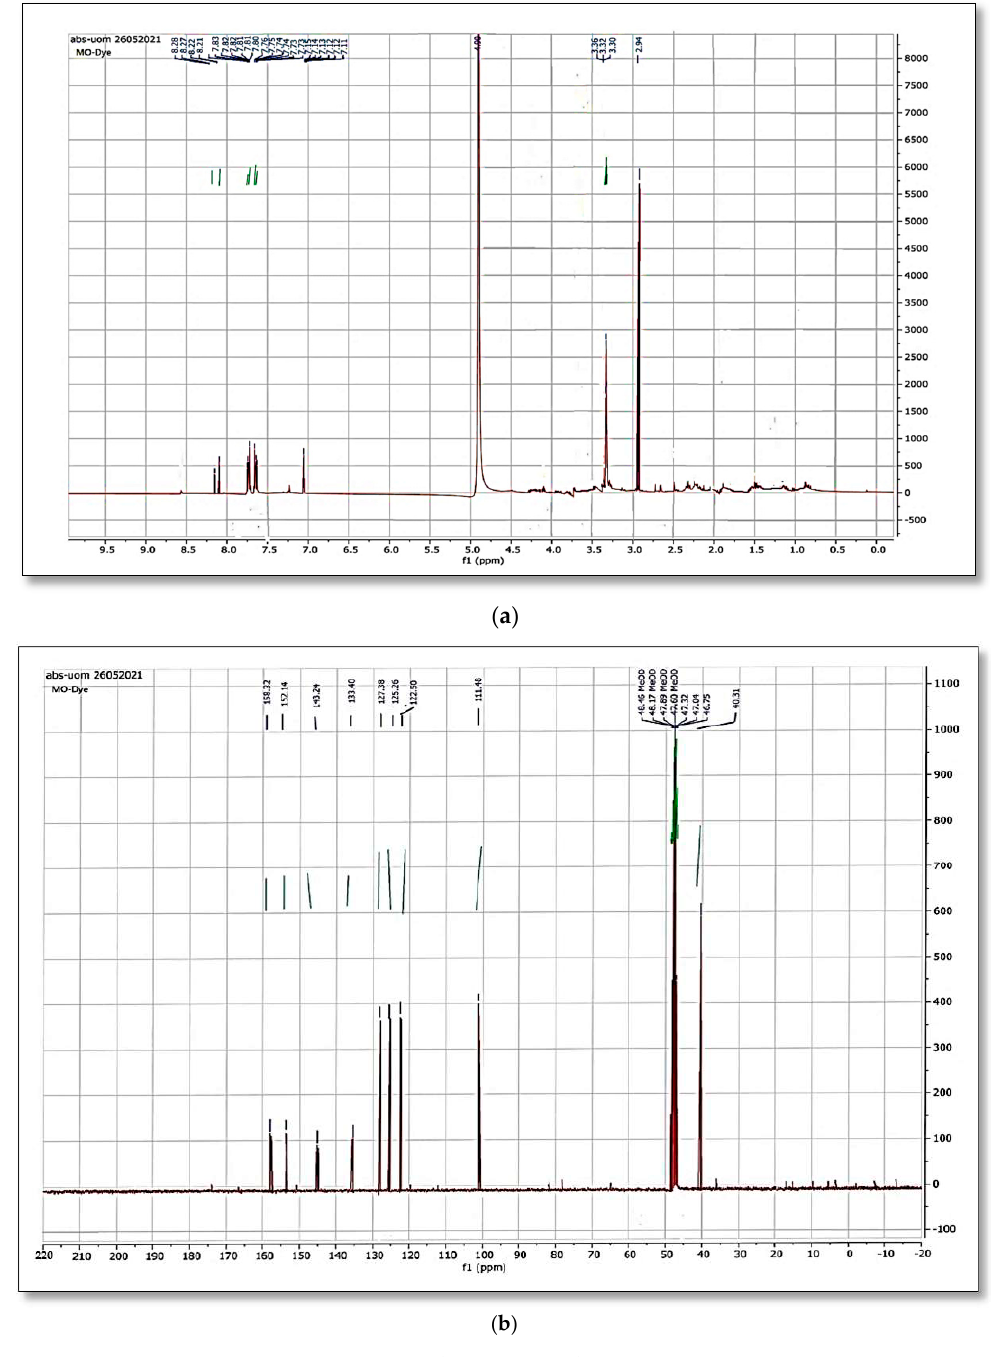
Figure 12. ( a ) Original dye methyl orange 1 H NMR. ( b ) 13 C NMR spectroscopy of the original dye, methyl orange.